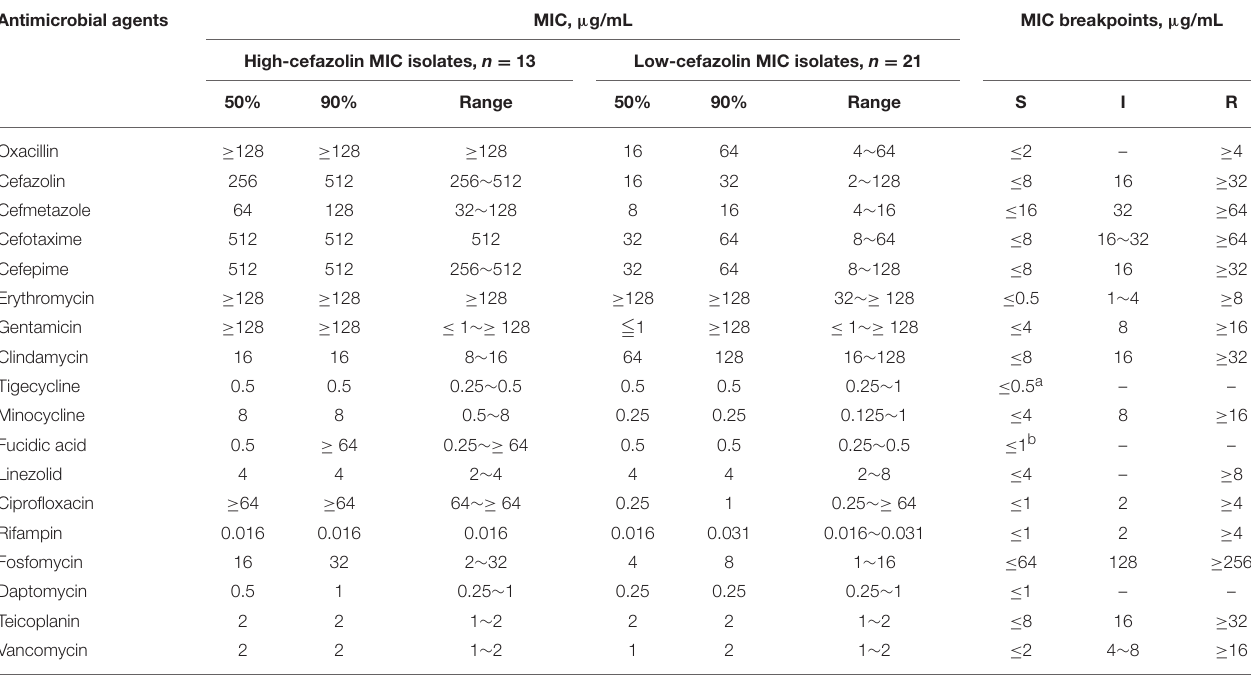
a breakpoint defined by FDA. b breakpoint defined by BSAC.